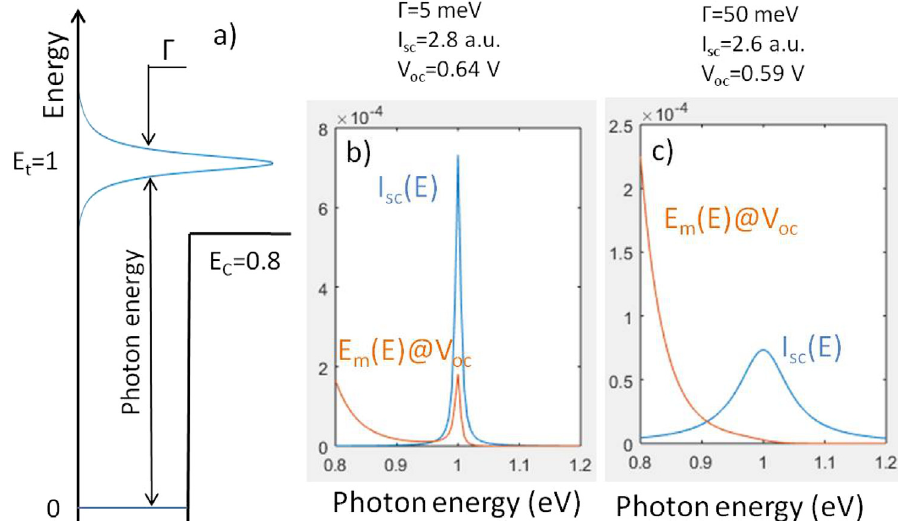
Fig. 5. (a) The schematically described detailed balance model and the corresponding I sc and E m spectra for (b) G = 5meV and for (c) G =